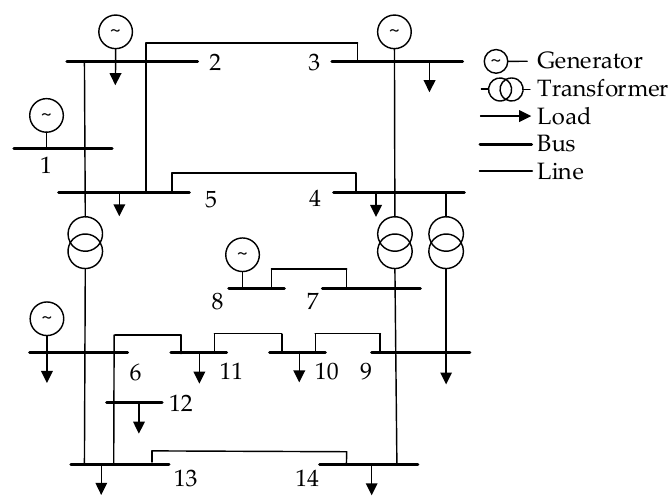
Figure 4. Single line diagram of the IEEE 14-bus system.